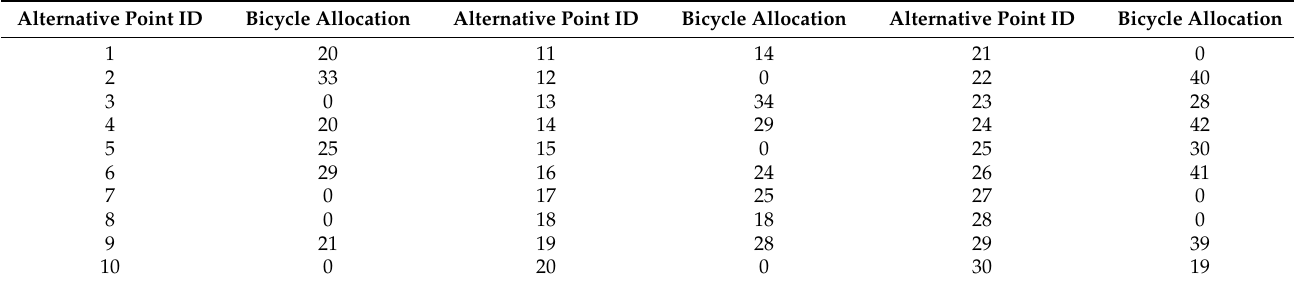
Table 4. The optimal scheme and the number of shared bikes